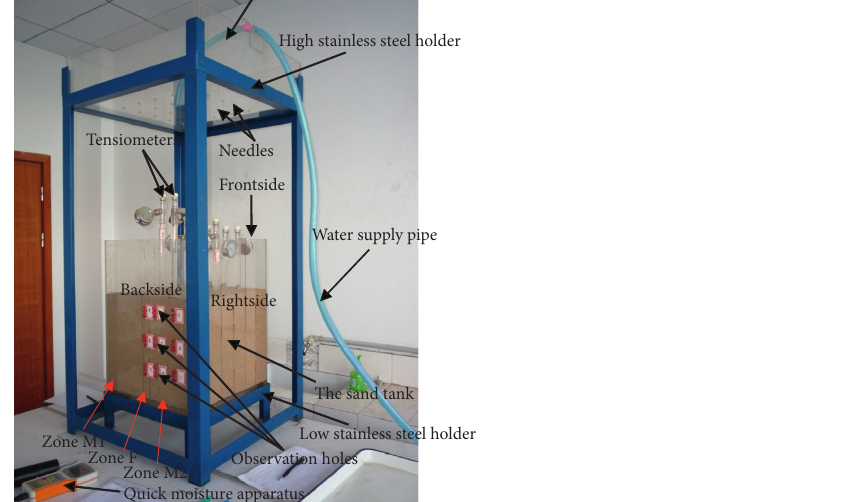
Figure 1: Illustration of the experimental setup.